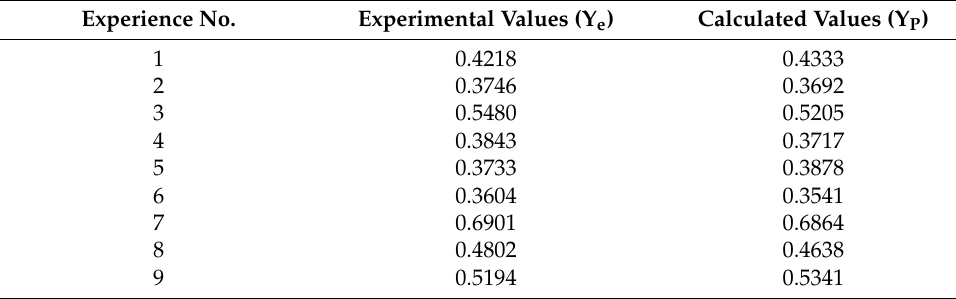
Table 7. Experimental and design values of hydrogenate yield. Experience